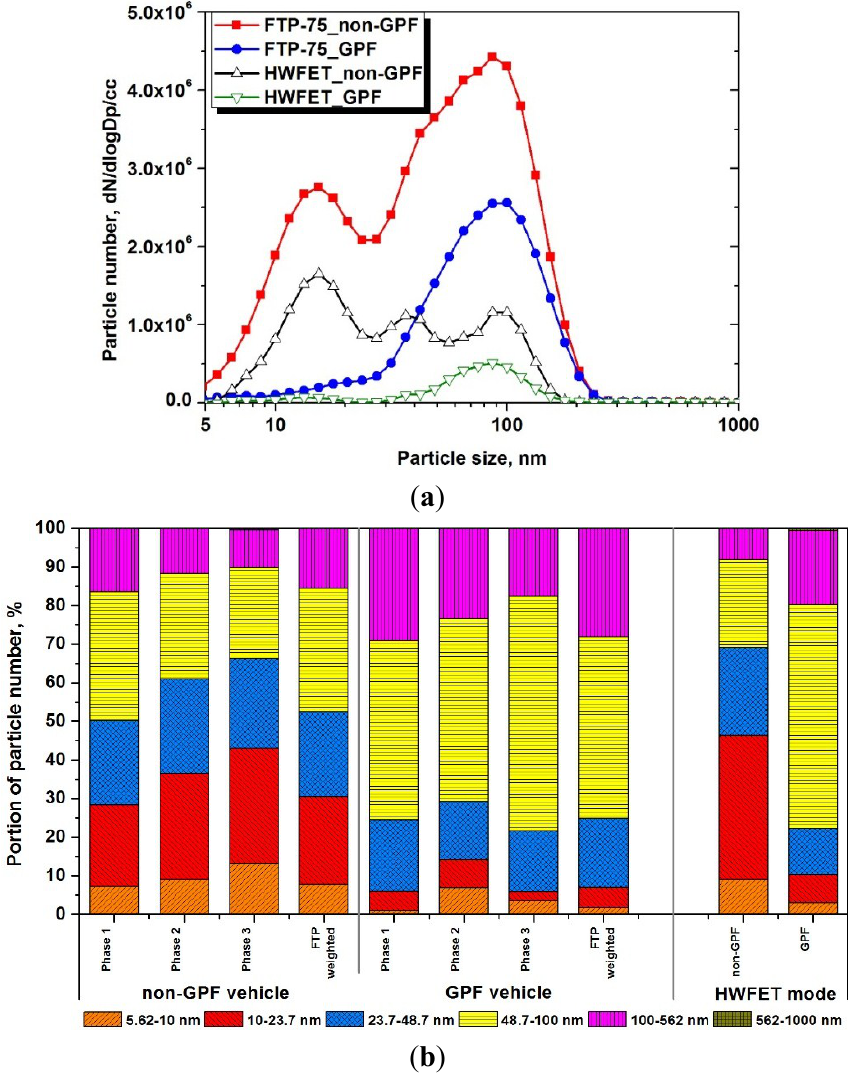
Figure 8. Comparison of size-resolved particle concentration and portion of particle number by DMS500 in FTP-75 and HWFET mode; ( a ) particle number concentration and size distribution; ( b ) portion of size-resolved particle number